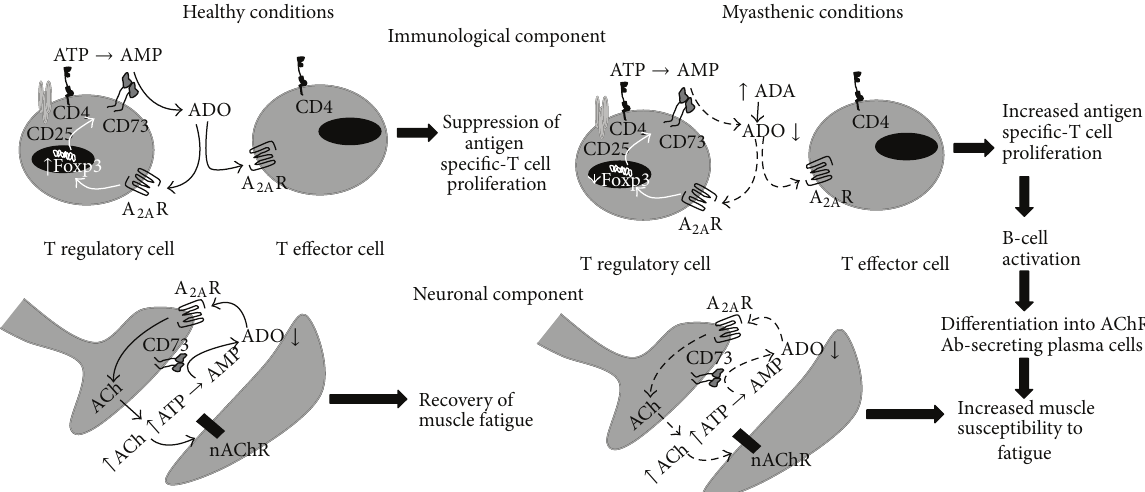
Figure 7: Participation of the adenosinergic system on neuroimmunological deficits present in EAMG rats. In healthy animals, A 2 R A activation by ADO generated from the catabolism of released nucleotides via ecto-5 󸀠 -nucleotidase/CD73 downmodulates T effector (CD 4 + CD 25 + FoxP 3 + ) cells (CD 4 + CD 25 + FoxP 3 − ) cells proliferation in response to specific antigens by increasing the activity of T reg expressing FoxP3-dependent gene products, like ecto-5 󸀠 -nucleotidase/CD73. At the neuromuscular junction, ecto-5 󸀠 -nucleotidase/CD73 activity leads to the formation of ADO from released ATP (from both nerve and muscle), which facilitates acetylcholine release via R activation that is necessary to resist tetanic depression. In EAMG rats, increases in serum adenosine deaminase (ADA) prejunctional A 2 A (CD 4 + CD 25 + FoxP 3 + ) cells lead to insufficient amounts of extracellular ADO. The lack together with ecto-5 󸀠 -nucleotidase/CD73 in T reg R immunosuppressive tonus contributes to the loss of peripheral tolerance to nAChR. Thus, increases in the proliferation of of the A 2 A antigen-specific T effector cells triggers B cells differentiation into plasma cells and secretion of antibodies directed towards motor endplates nAChR clusters. This antibody attack leads to nAChR internalization/degradation and to complement-mediated morphological changes of the myasthenic postsynaptic membrane (e.g., fewer secondary synaptic folds, widening of the synaptic cleft). These changes contribute to neuromuscular transmission failure, which is further aggravated by deficits in the production of extracellular ADO, probably from released R-mediated facilitation of transmitter Impairment of tonic A 2𝐴 R-mediated adenine nucleotides, namely, ATP. Impairment of tonic A 2 A facilitation of transmitter release turns myasthenic skeletal muscles unable to resist